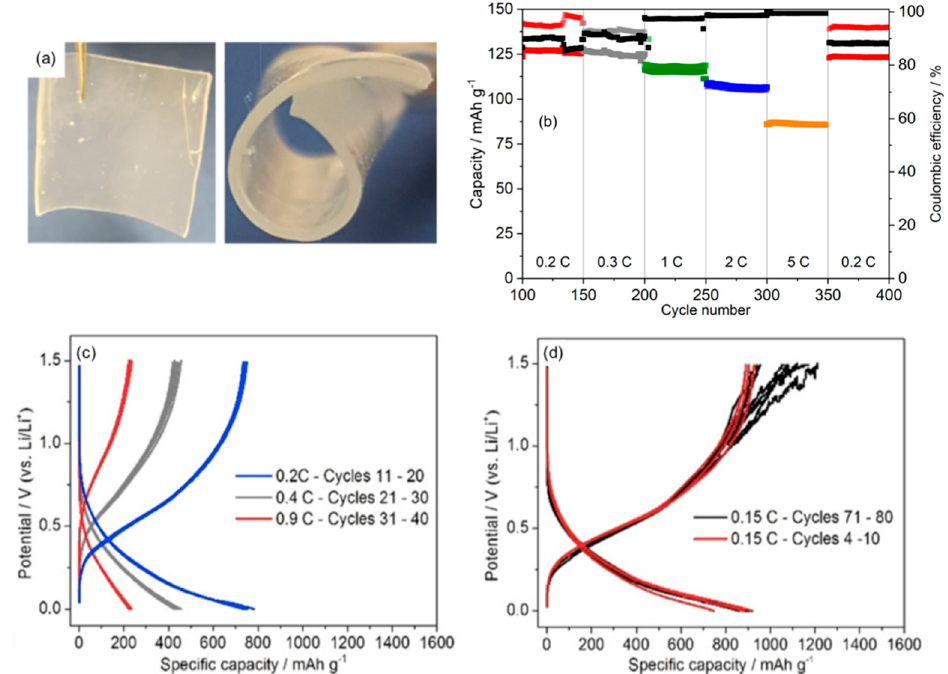
Figure 10. ( a ) Optical images of the 400 µm thick polymer gel synthesized, ( b ) long-term galvanostatic cycling data for V 2 O 5 /Li cells at indicated C-rates and ( c , d ) Ge galvanostatic profiles obtained at indicated C-rates. ( a , c , d ) Reprinted with permission from McGrath et al. [195].